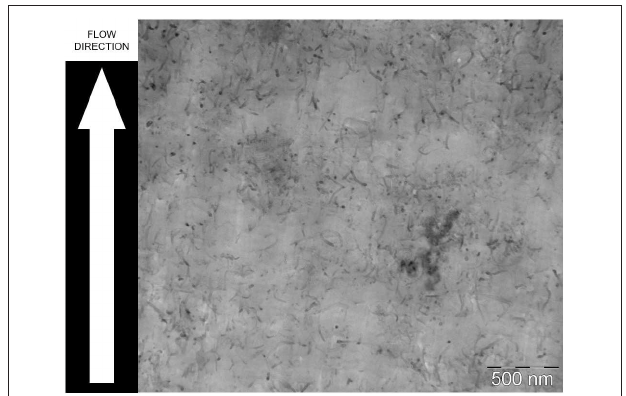
FIGURE 3 | TEM micrograph of ABS/CNT nanocomposite filament in parallel section.